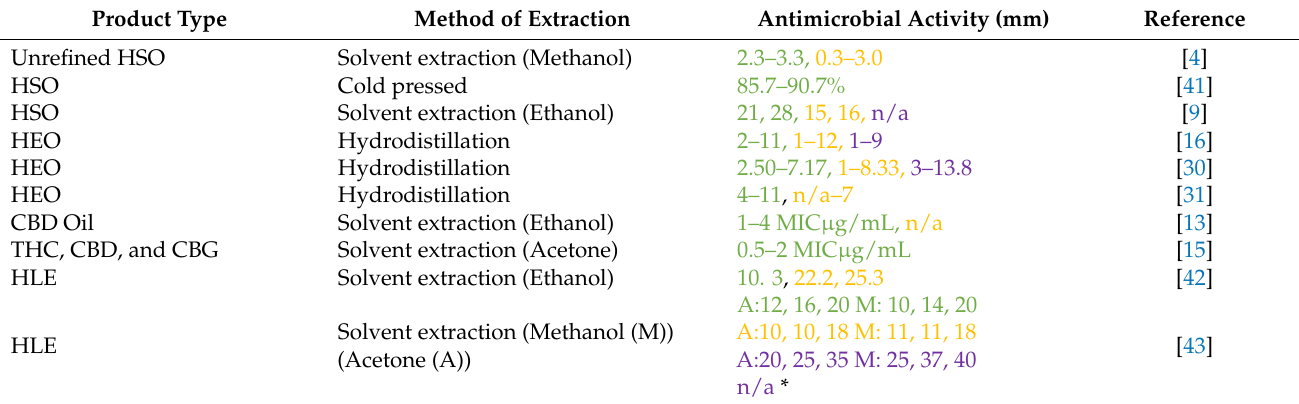
Table 2. Extraction methods on the effect on antimicrobial activity on hemp